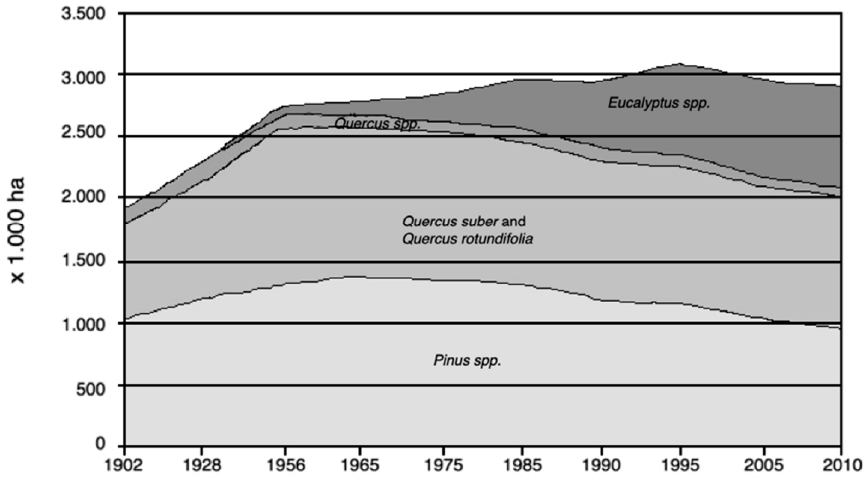
Figure 5. Changes in the area covered by the major tree species in mainland Portugal between 1902 and 2010 (adapted from [27]).